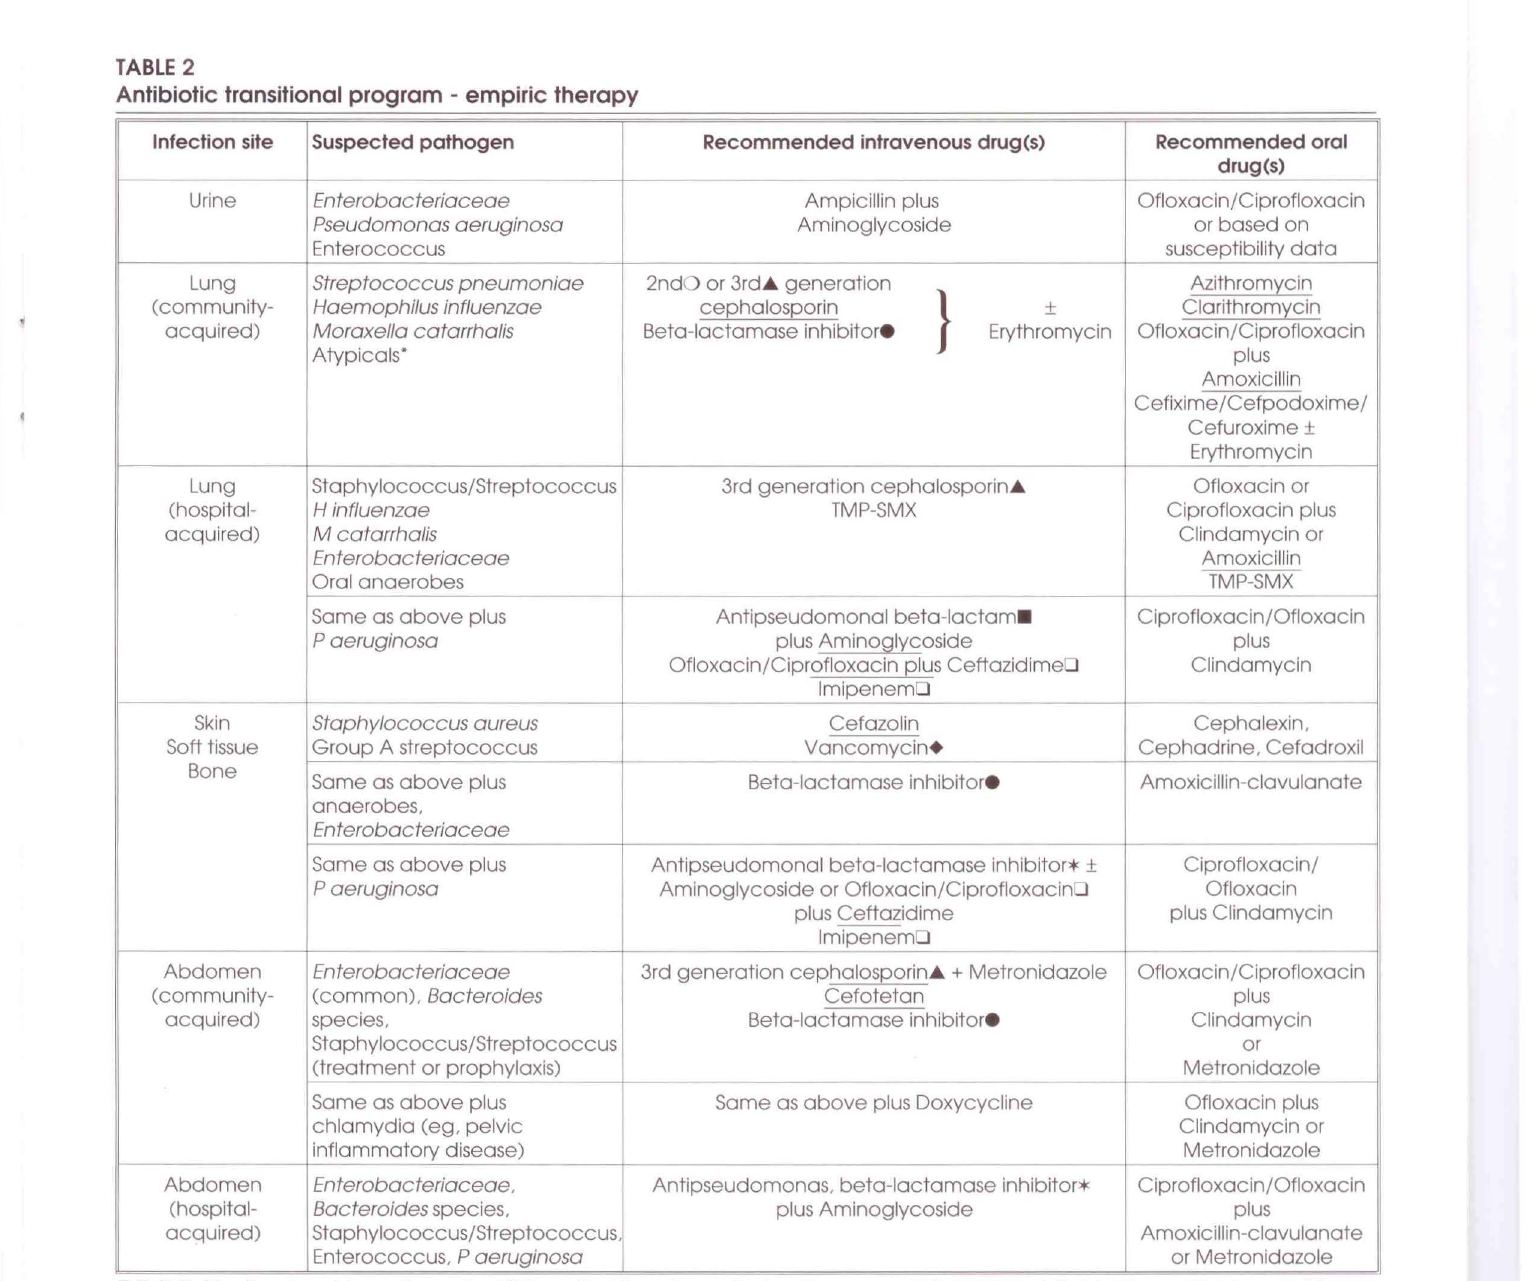
Antibiotic transitional program - empiric